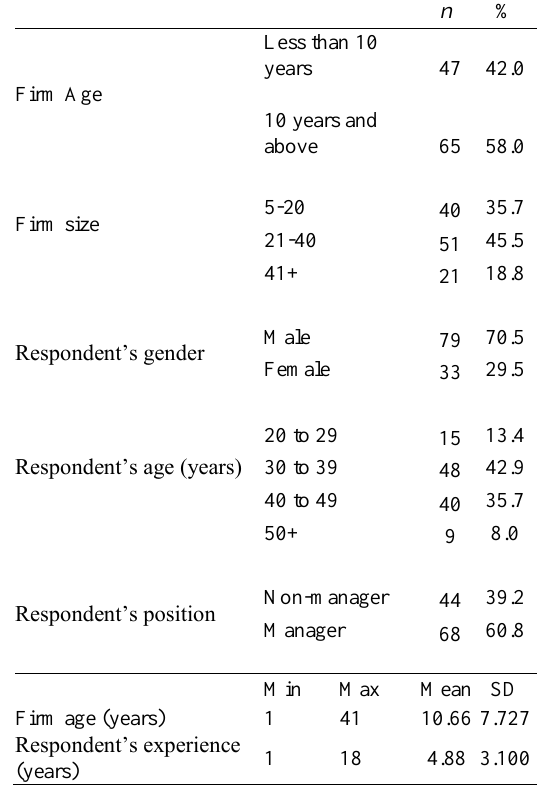
Table 4: Firm and Respondent